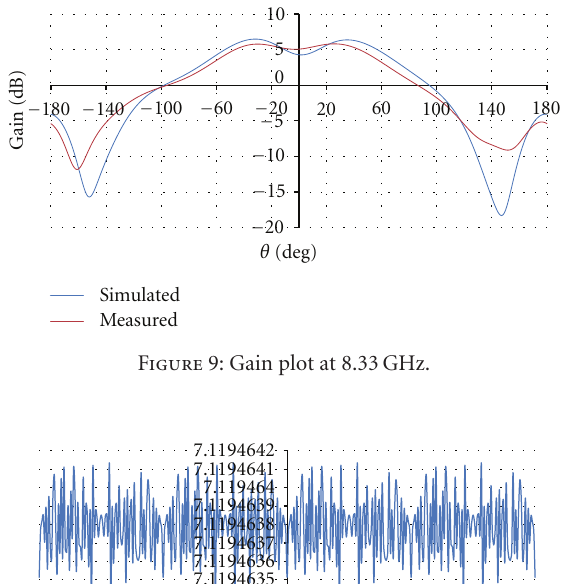
Figure 6: Frequency response of dual-mode DRA (near field measurement).